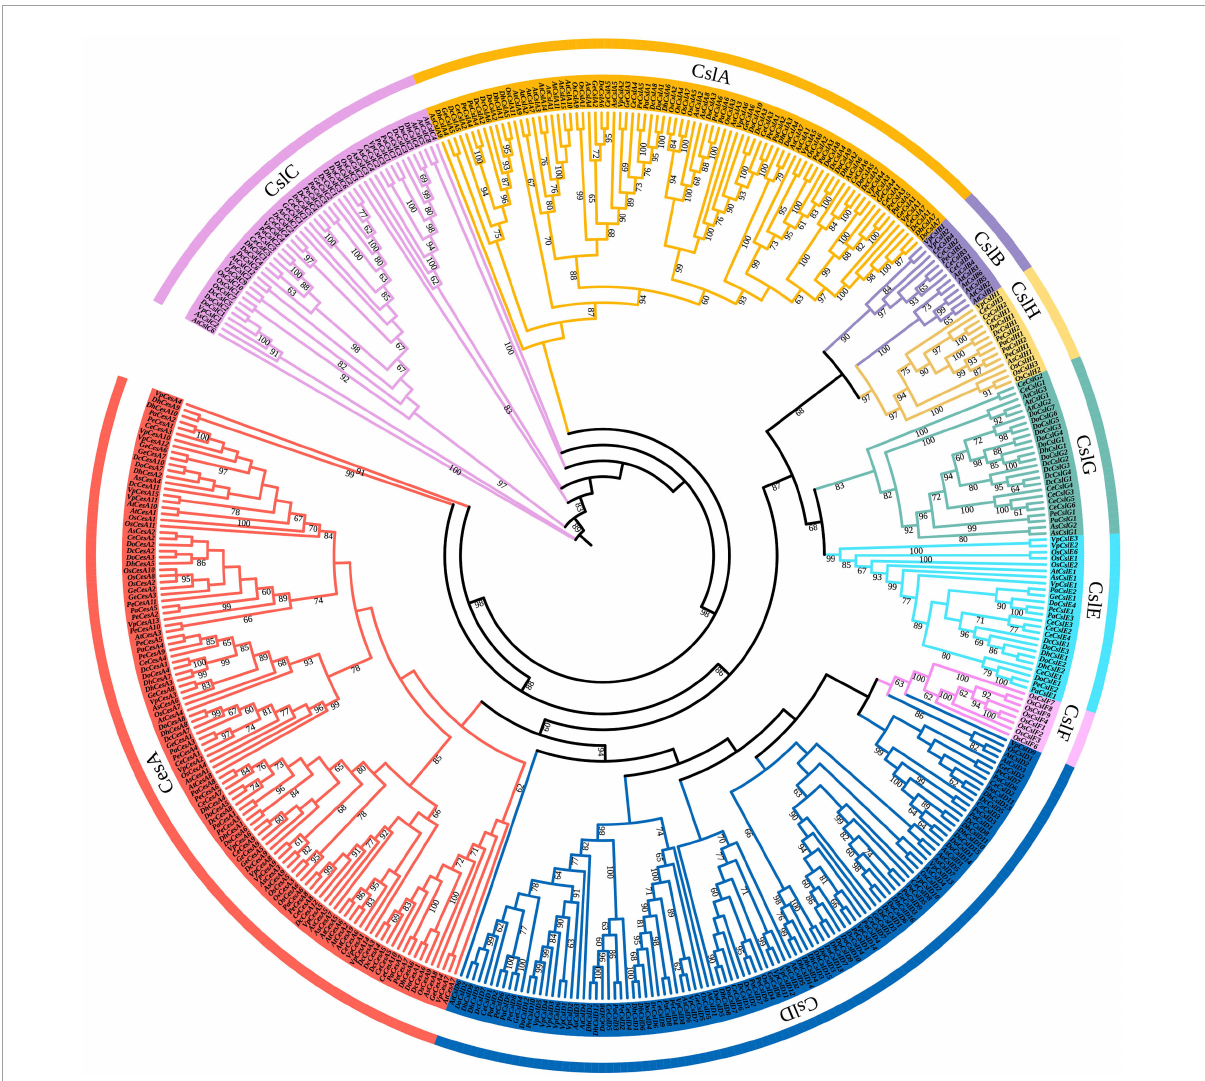
FIGURE1 Phylogenetic tree of CesA/Csl superfamily for nine orchid species as well as A. thaliana and O. sativa . CesA, CslA, CslB, CslC, CslD, CslE, CslF, CslG, and CslH are nine subfamilies. The different colored blocks represent the distribution of different subfamilies. The numbers on the branches represent the bootstrap value